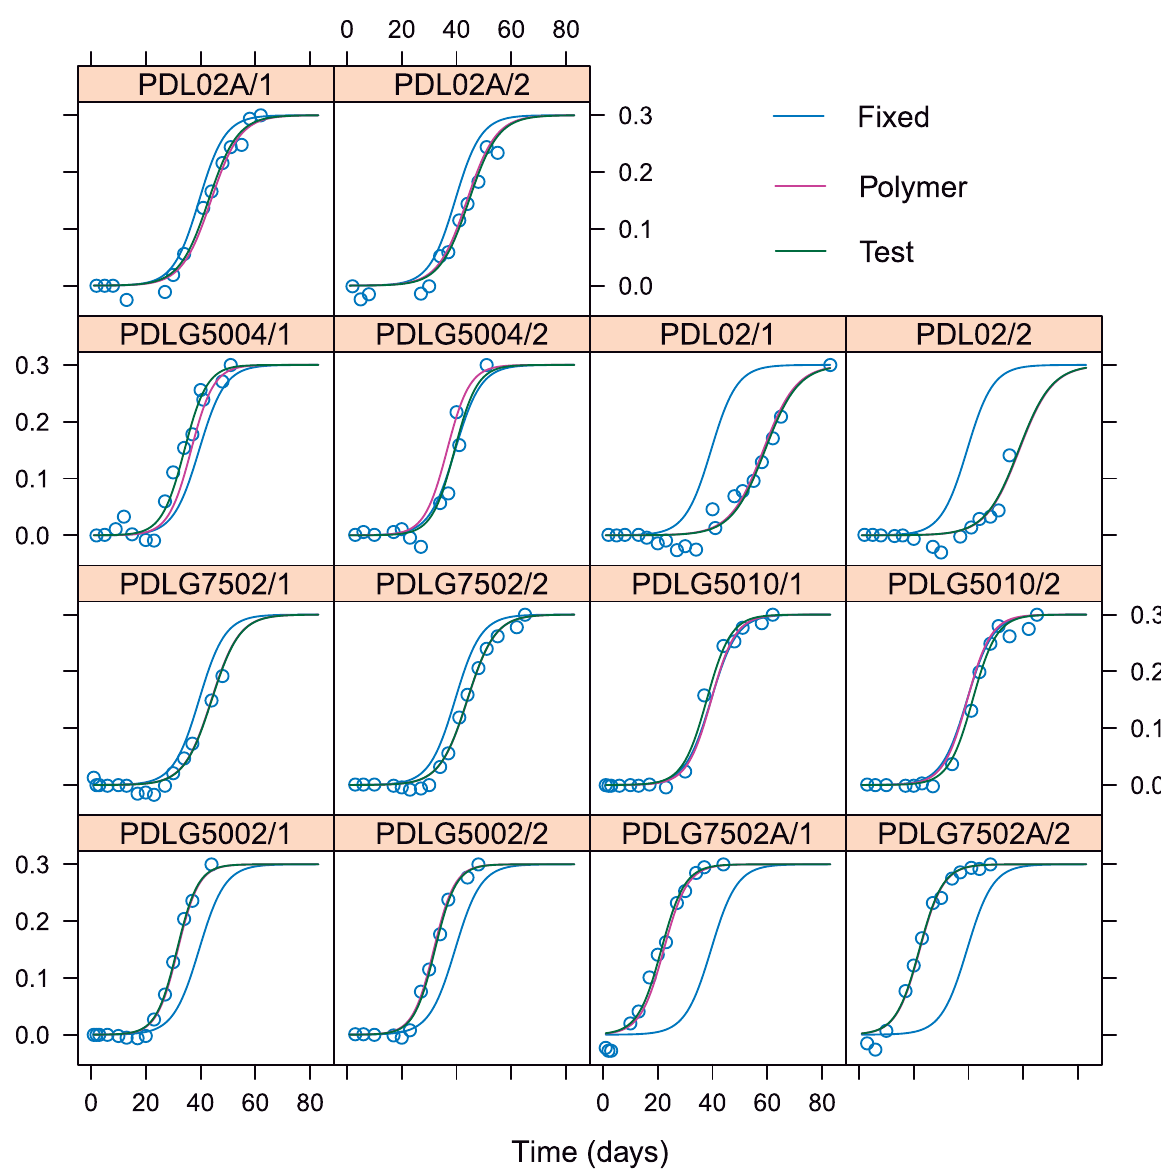
Fig 8. Each panel shows the PDLGA mass loss versus time for each test/replicate corresponding to each PDLGA polymer. The nonlinear mixed- effects fitting for each test is shown and compared with respect to fittings corresponding to each polymer, and the fitting corresponding to the population (and obtained using the fixed effects of model parameters).